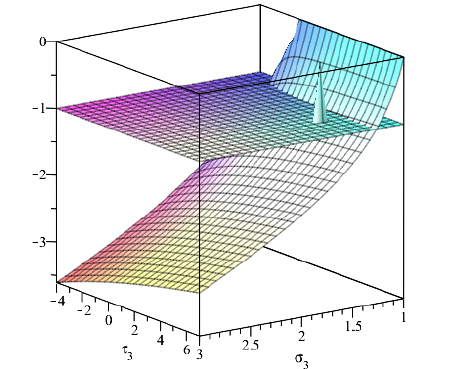
Figure 2 . Comparison between the lowest eigenvalue of R 2 M 2 and the BF bound, which is -1 AdS in this case. There are regions of stability for values of (cid:27) 3 close to 1, which correspond to R 2 > 9 R 2 AdS and negative values of V 0 . The example displayed here refers to ‘ = 3, which corresponds to the minimum in the orientifold case of (cid:12)gure 1, and the peak identi(cid:12)es the point corresponding to the tree-level values (cid:27) 3 = 3 , (cid:28) 3 = 9 . 2 2